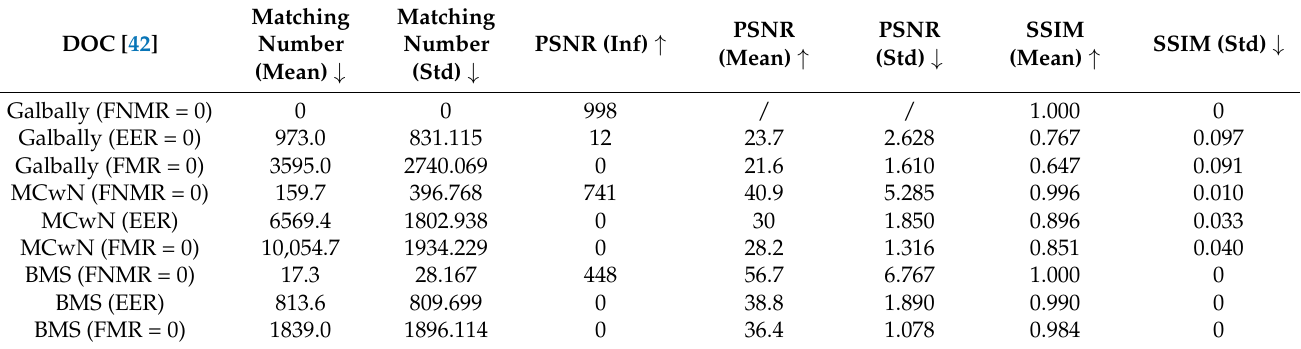
Table 9. Attack performance of DOC [42]. Table 10. Attack performance of DRCC [43].